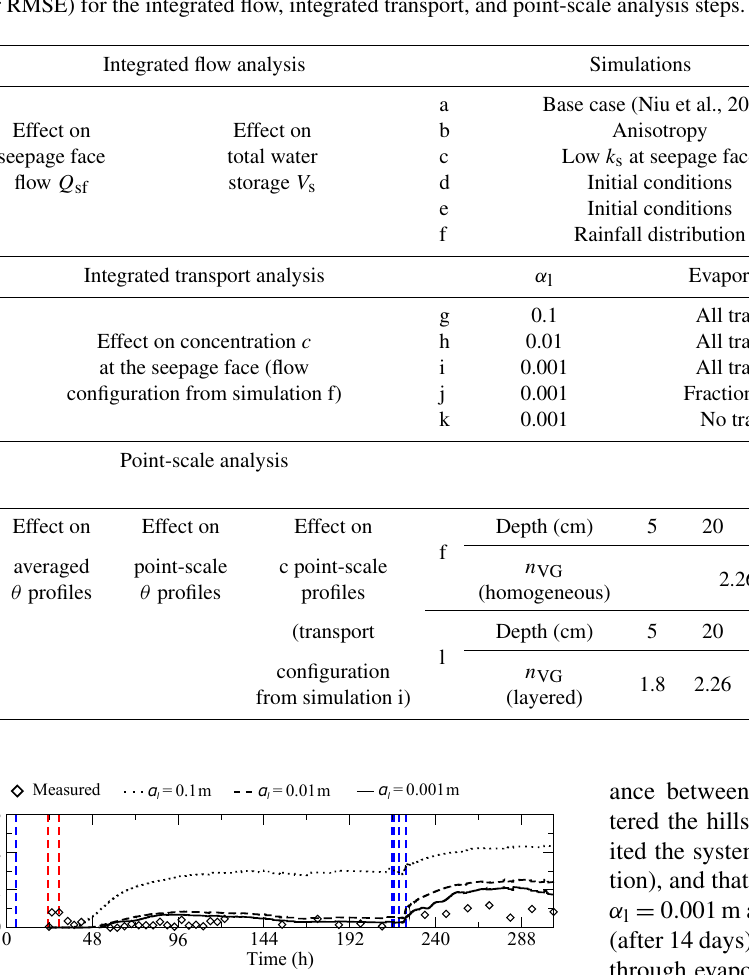
Figure 5. Results for the integrated transport response analysis for different values of dispersivity (simulations g, h, and i of Table 3). The vertical dashed lines indicate the timing of the three pulses of rain (red when the water is 2 H -enriched and blue when it is